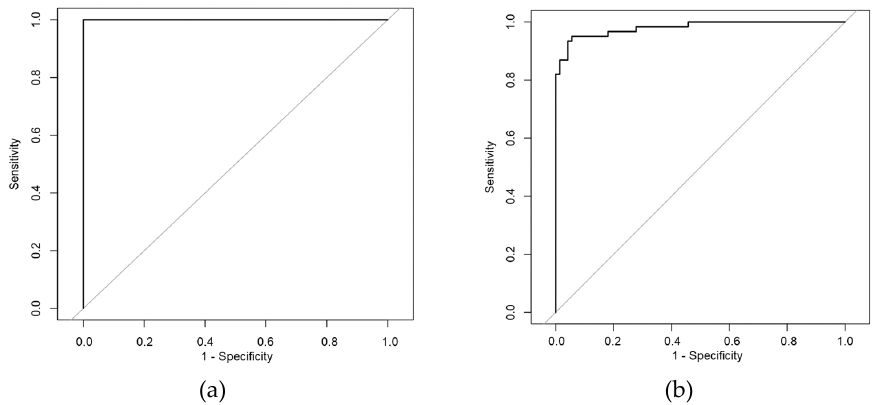
dataset or the split segment EEG signals dataset). Under the two data sets, the ROC curves at the highest AUC value are shown in Figure 4.